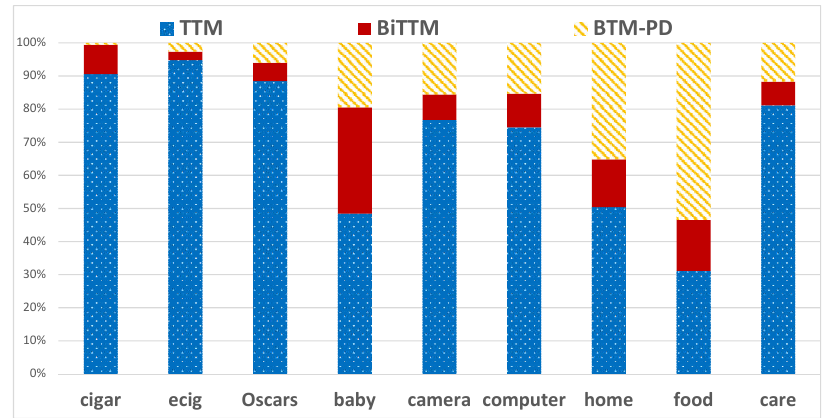
Figure 6. Time cost in datasets with different document lengths.